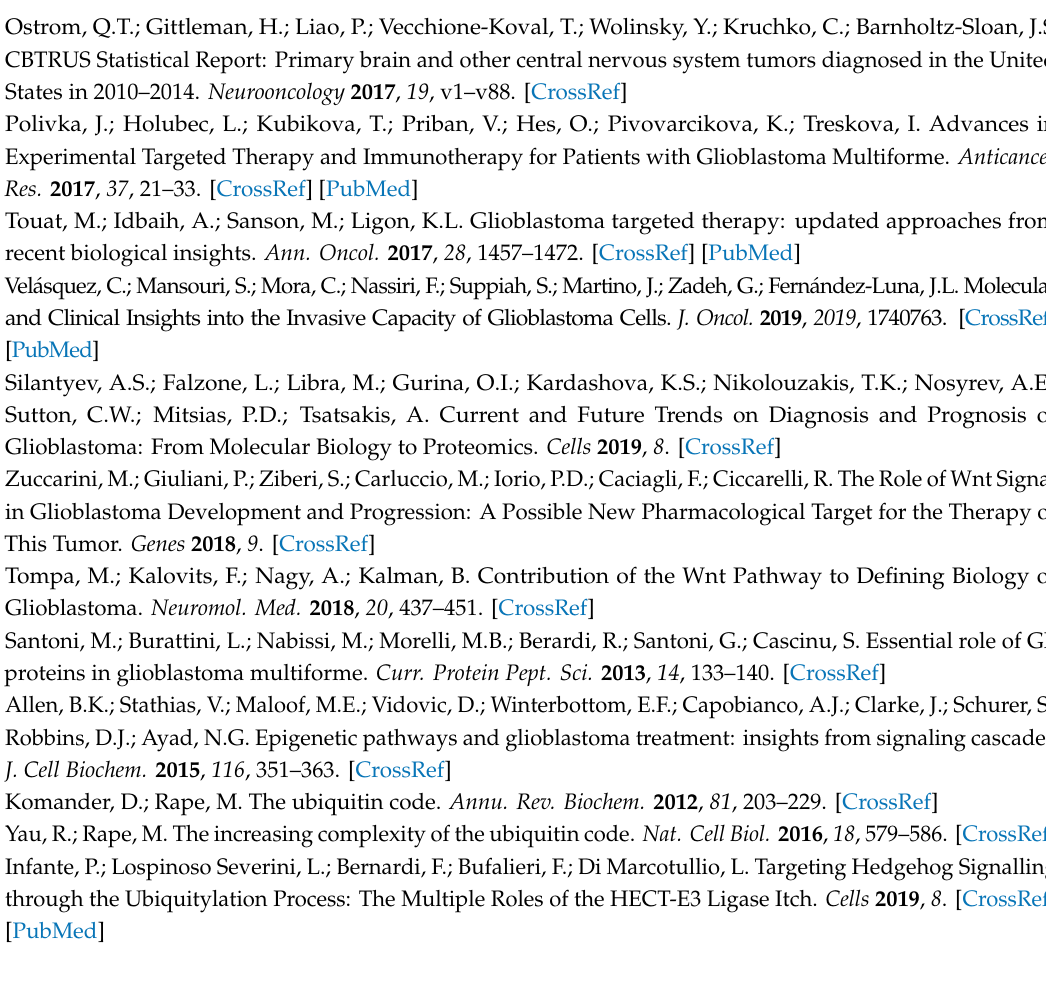
Figure S1: MEX3A gene expression profile in normal brain tissues and di ff erent GB datasets from R2 Genomics Analysis and Visualization Platform, Figure S2, MEX3A activity does not a ff ect RIG-I mRNA levels. Figure S3, E ff ect of MEX3A genetic depletion on migration of A-172 and T98Gcell lines., Figure S4, Uncropped blots of Western Blot figures. Table S1: Gene expression level of the significantly modulated catalytic E3 ubiquitin ligases and F-box proteins in GB compared to normal brain tissues from GEPIA, Table S2, Specific characteristics of individual patient